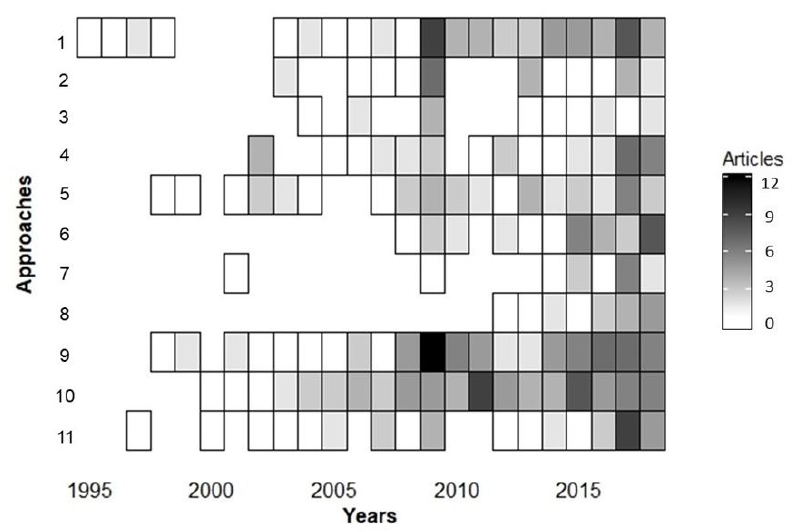
Figure 6. Number of articles from different theoretical approaches from 1995 to 2018 found on the Web of Science (ISI) database. 1. Community structure, 2. Flood pulse, 3. Bus effect, 4. Genetic approach, 5. Spatial and temporal variation, 6. Species invasion, 7. Beta diversity, 8. Functional approach, 9. Species characterization, 10. Other ecological approaches, 11. General (health-related approaches,